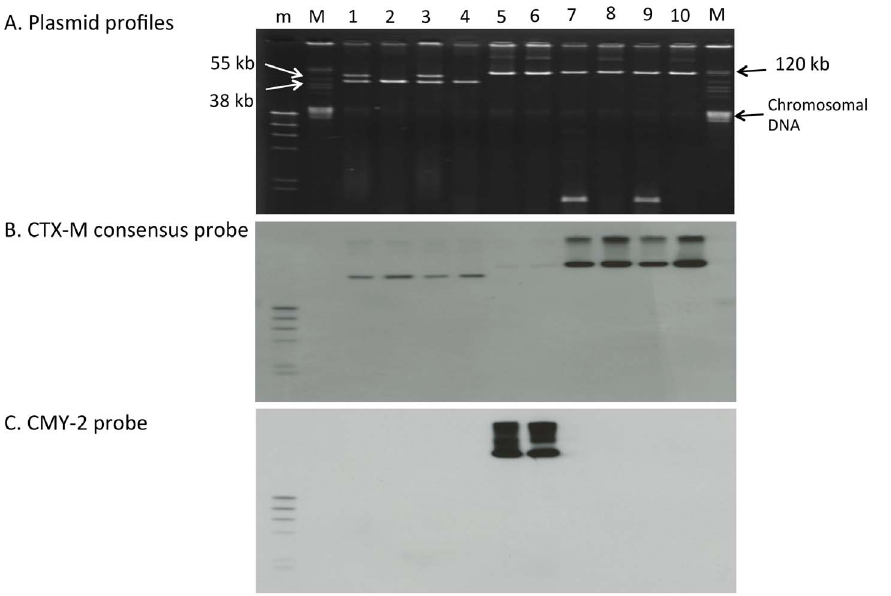
Figure 2. Plasmid profiling and Southern hybridization of b -lactamase genes in E.coli isolates from CTF-treated cattle. A, Plasmid profiling. B, Southern hybridization of the bla CTX-M consensus probe. C, Southern hybridization of the bla CMY-2 probe. Lane1, ML4909 (recipient); lane 2, TC7-1 (possesses bla CTX-M-2 ); lane 3, TcTC7-1; lane 4, TC7-2 (possesses bla CTX-M-2 ); lane 5, TcTC7-2; lane 6, TC7-9 (possesses bla CMY-2 ); lane 7, TcTC7-9; lane 8, TC13-1 (possesses bla CTX-M-14 ); lane 9, TcTC13-1; lane 10, TC13-2 (possesses bla CTX-M-14 ); lane 11, TcTC13-2; m, DNA Molecular Weight Marker II, DIG-labeled; M, BAC-Tracker Supercoiled DNA Ladder. bla CTX-M-2 and bla CTX-M-14 were detected using a CTX-M consensus probe.